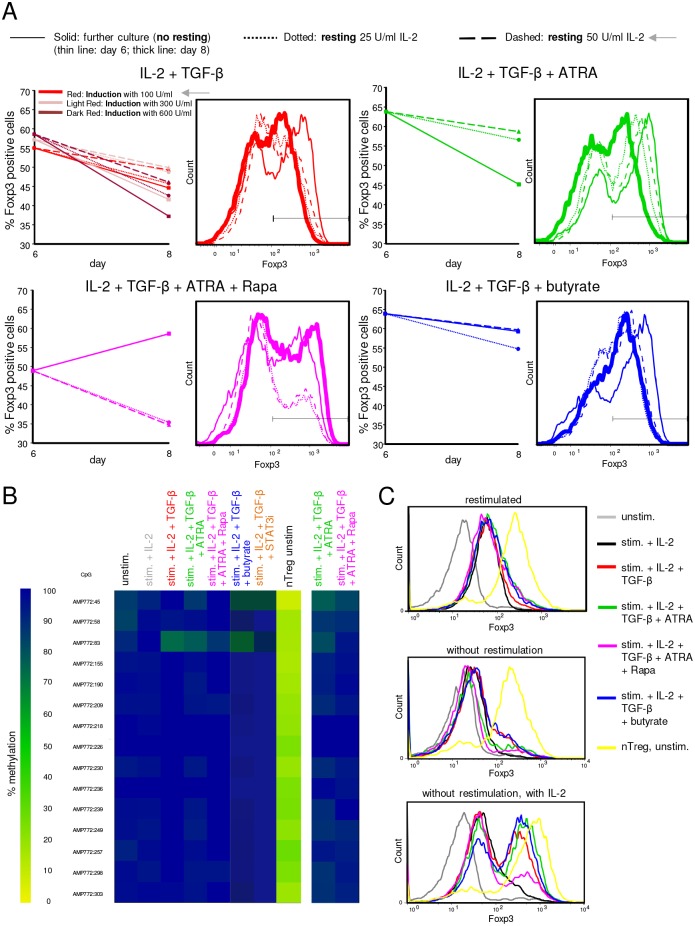
Analysis of Foxp3 stability and TSDR demethylation in human iTregs.(A) iTregs were induced for 6 days under the indicated conditions, with 100 U/ml IL-2 if not otherwise stated. Foxp3 protein expression on day 6 is shown as solid, thin line. After 6 days, iTregs were either further cultured 2 days (thick line) or washed and rested in medium containing only IL-2, either 25 U/ml (dotted lines) or 50 U/ml (dashed lines). Left panels show the percentage of Foxp3+ cells, right panels show FACS histogram overlays for corresponding Foxp3 stainings. The “standard”conditions (100 U/ml IL-2 for induction, 50 U/ml IL-2 for resting) are marked by grey arrows. Gate: Live CD4+ cells. Shown is a representative donor (out of 4 to 6 for standard conditions; out of 2 for IL-2 titrations during induction). (B) TSDR DNA demethylation was analyzed at day 6 of Treg induction under the indicated conditions (left panel), or on day 8 after resting (two lanes on the right). Tnaive and nTreg DNA was isolated on day 0 as control. T cells were isolated from a male donor, and a representative donor out of 2 to 4 is shown. The color scale indicates 0 to 100% methylation at the given CpG nucleotides in the Foxp3 locus. (C) iTregs or control cells were cultured for 6 days under the indicated conditions, then rested 2 days, and further cultured for 5 days with restimulation, or without restimulation and without or with IL-2 (upper, middle and lower panel, respectively). nTregs were cryopreserved after isolation, thawed on day 6 and rested 2 days, and then treated in parallel with iTregs as a control. Intracellular Foxp3 expression was measured by flow cytometry, gated on live CD4+ cells. Shown is a representative donor out of 4.